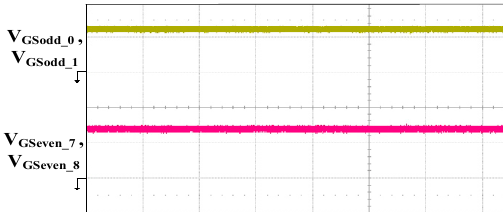
Figure 12. Experiment of V GS triggering waveforms for turning on the switch network (V GSodd_0 , V GSodd_1 , V GSeven_7 , V GSeven_8 ), V GSodd_0 , V GSodd_1 , V GSeven_7 , V GSeven_8 : 10 V/div, Time: 20 µs/div.